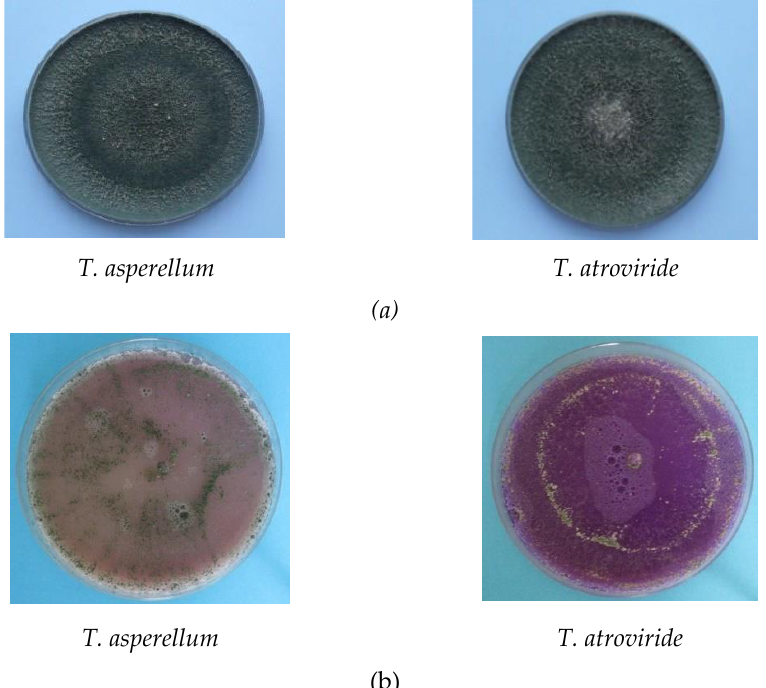
Figure 4. Qualitative tests for Trichoderma isolates traits. ( a ) qualitative test for siderophores production on 8-hydroxychinoline medium by Trichoderma isolates. ( b ) qualitative test for phosphate solubilization by Trichoderma isolates. Picture showed the color difference between tested fungal isolates.